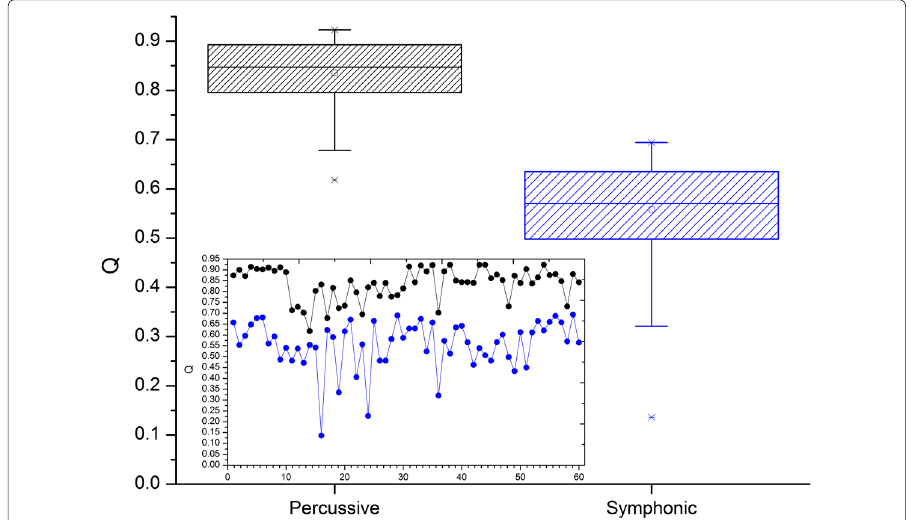
Fig. 4 Modularity of 60 Percussive (boxplot and dots in black) and Symphonic (boxplot and dots in blue) visibility networks. Source: